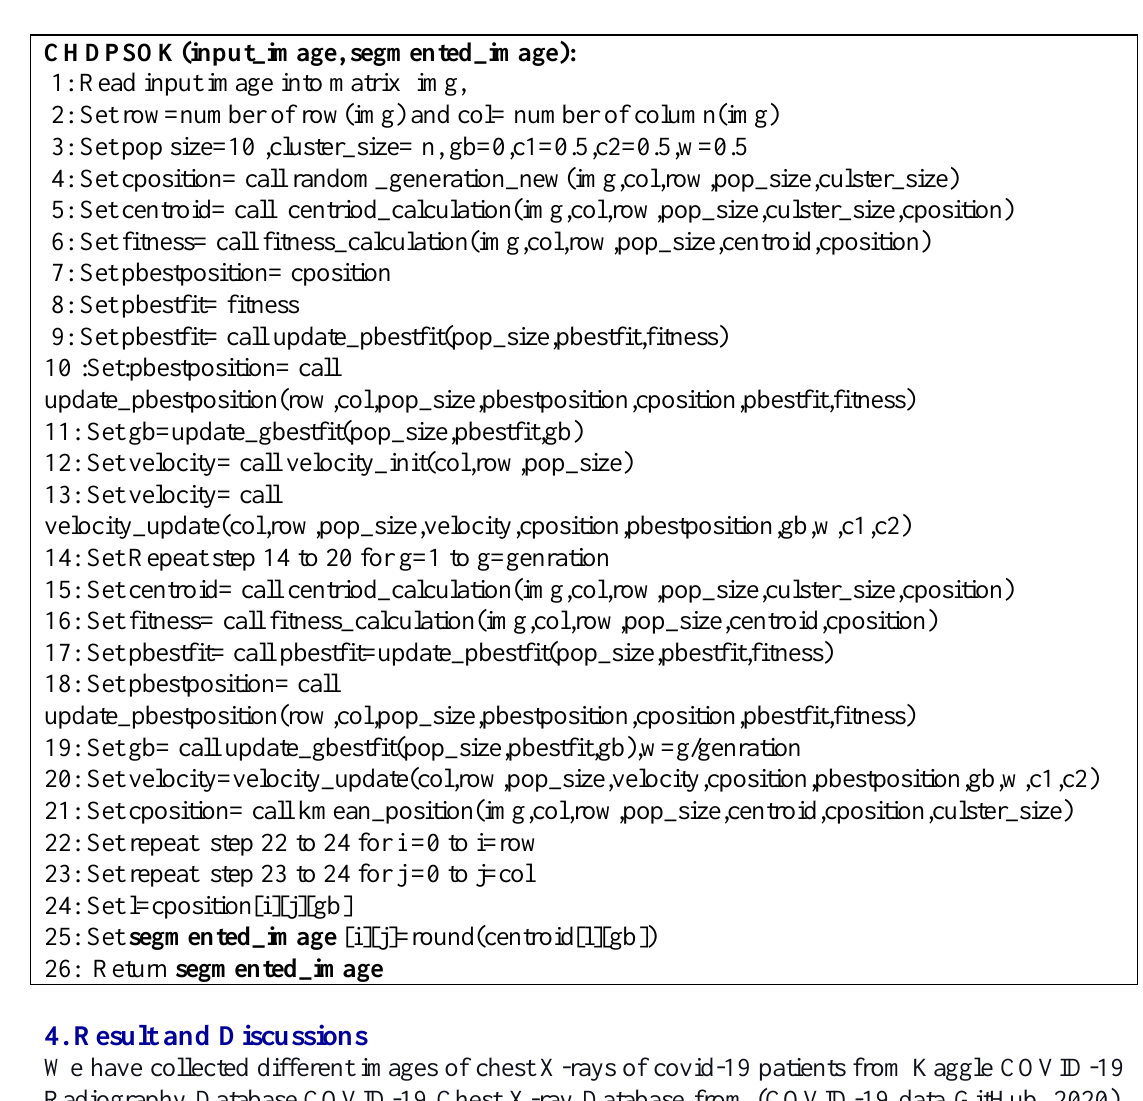
Algorithm 9. Proposed Algorithm